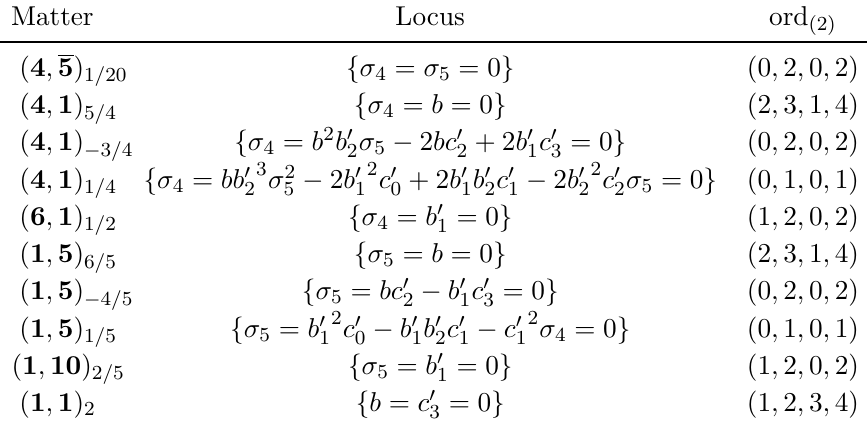
Table 22. Matter loci for the su (4) ⊕ su (5) ⊕ u (1) model, along with the codimension-two orders of vanishing of (ˆ x, ˆ y, ˆ z, ˆ w ) . In addition to the matter loci listed here, there are ( 1 , 1 ) singlets located 1 at loci where ˆ y/ ( σ ) and ˆ w/ ( σ ) simultaneously vanish that are not part of the matter loci 4 σ 5 4 σ 5 above. The model may also have delocalized ( 6 , 1 ) and ( 1 , 10 ) adjoint matter that can propagate 0 0 along the { σ = 0 } and { σ = 0 } gauge 4 5